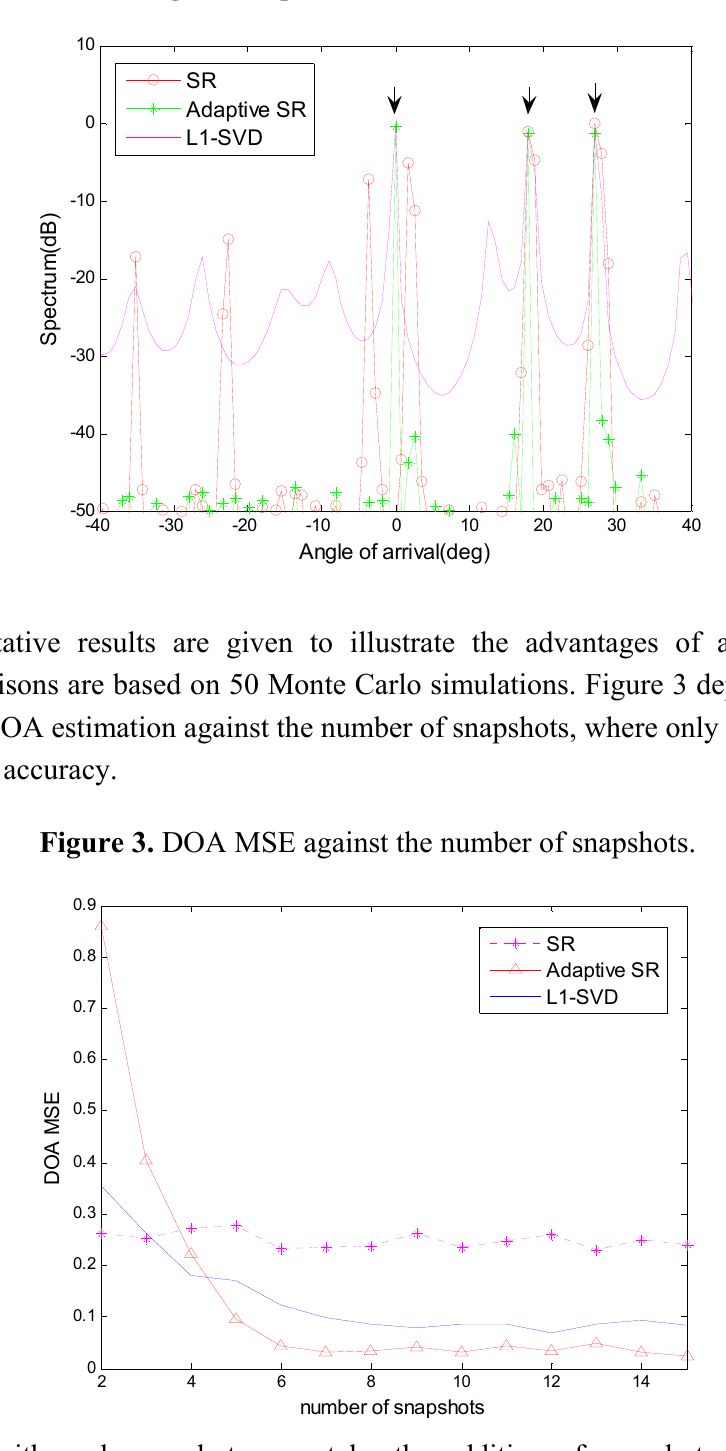
Figure 2. Spectrum estimation result.